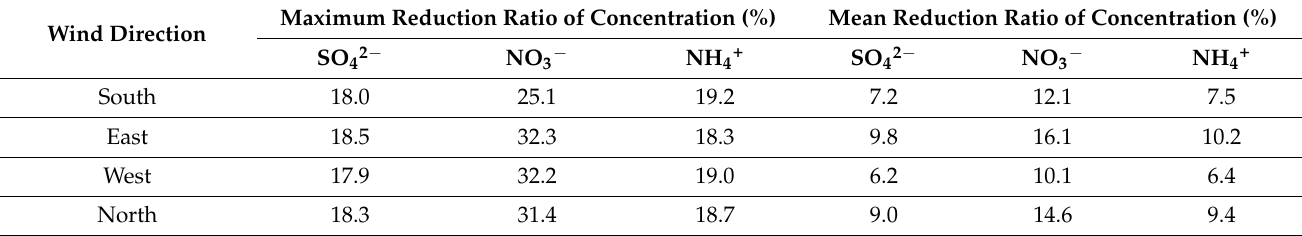
Table 7. Maximum and average concentration reduction ratio (%) depending on wind direction by species. Wind